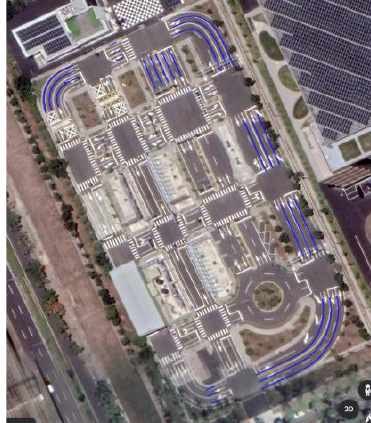
Figure 10. The converted result in Google Earth (from Google Earth).